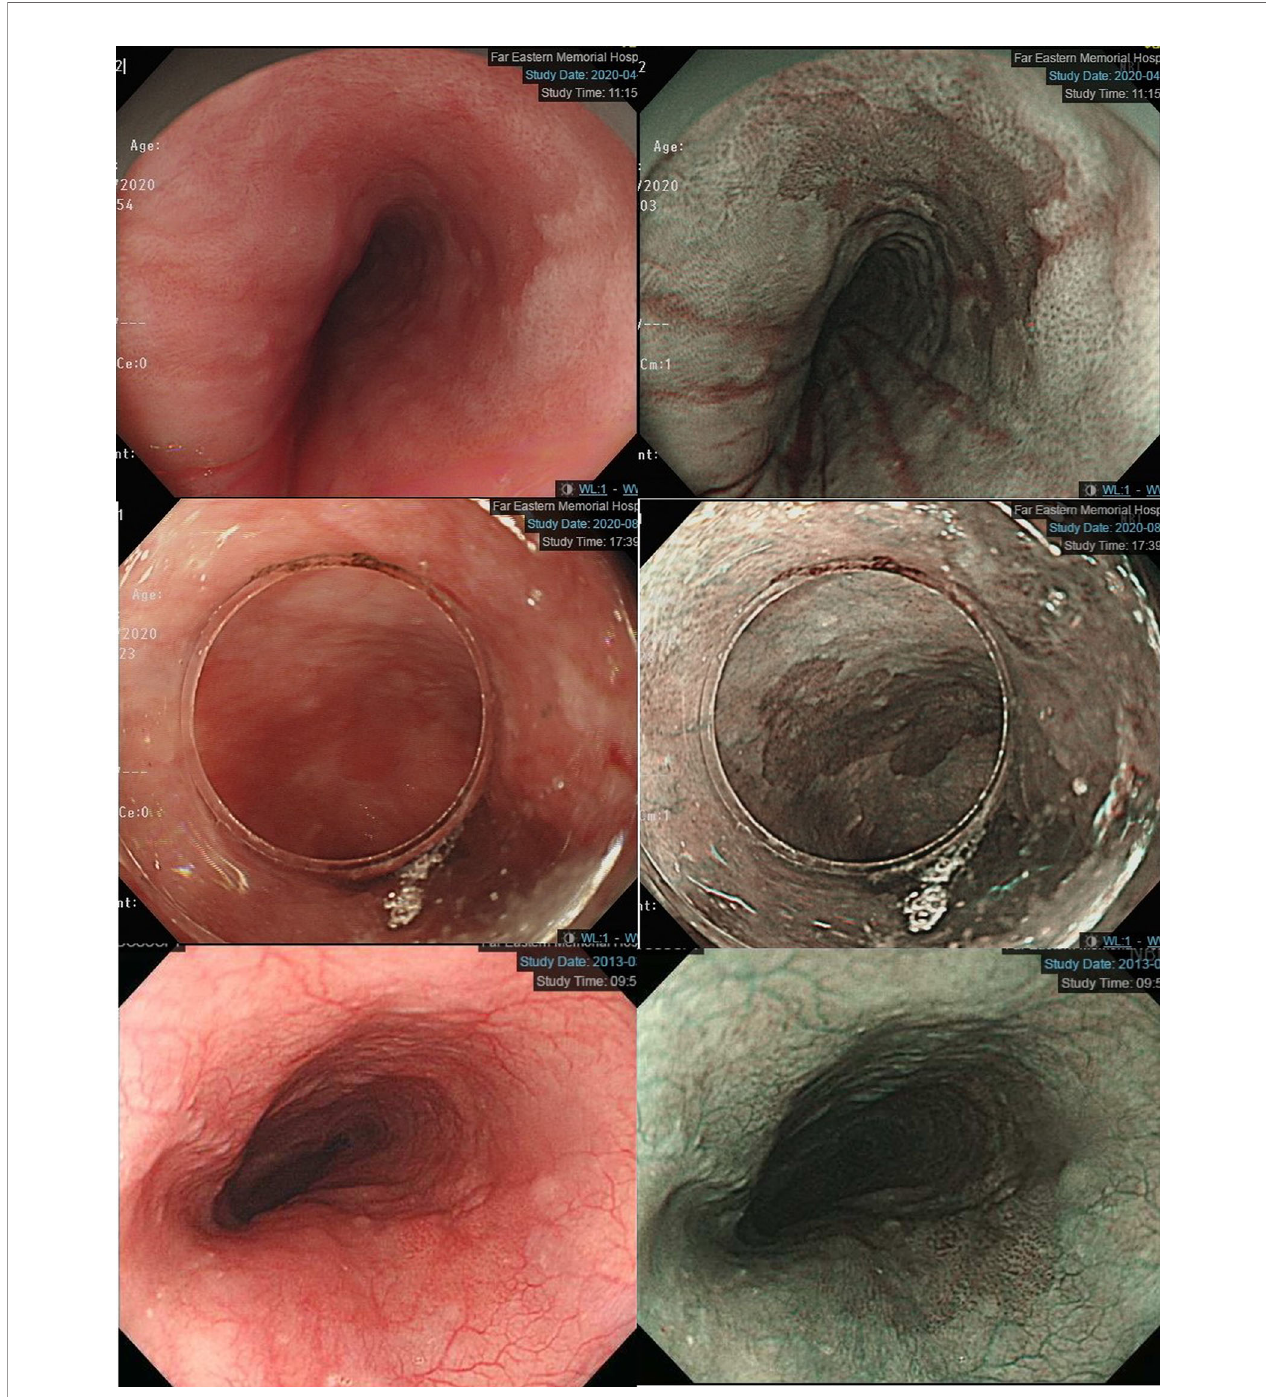
FIGURE 5 | Left panels : Early esophageal neoplasm with barely visible fl at morphology under conventional white-light endoscopy. Right panels : Dark brownish color compared with the greenish color of healthy mucosa under narrow-band imaging